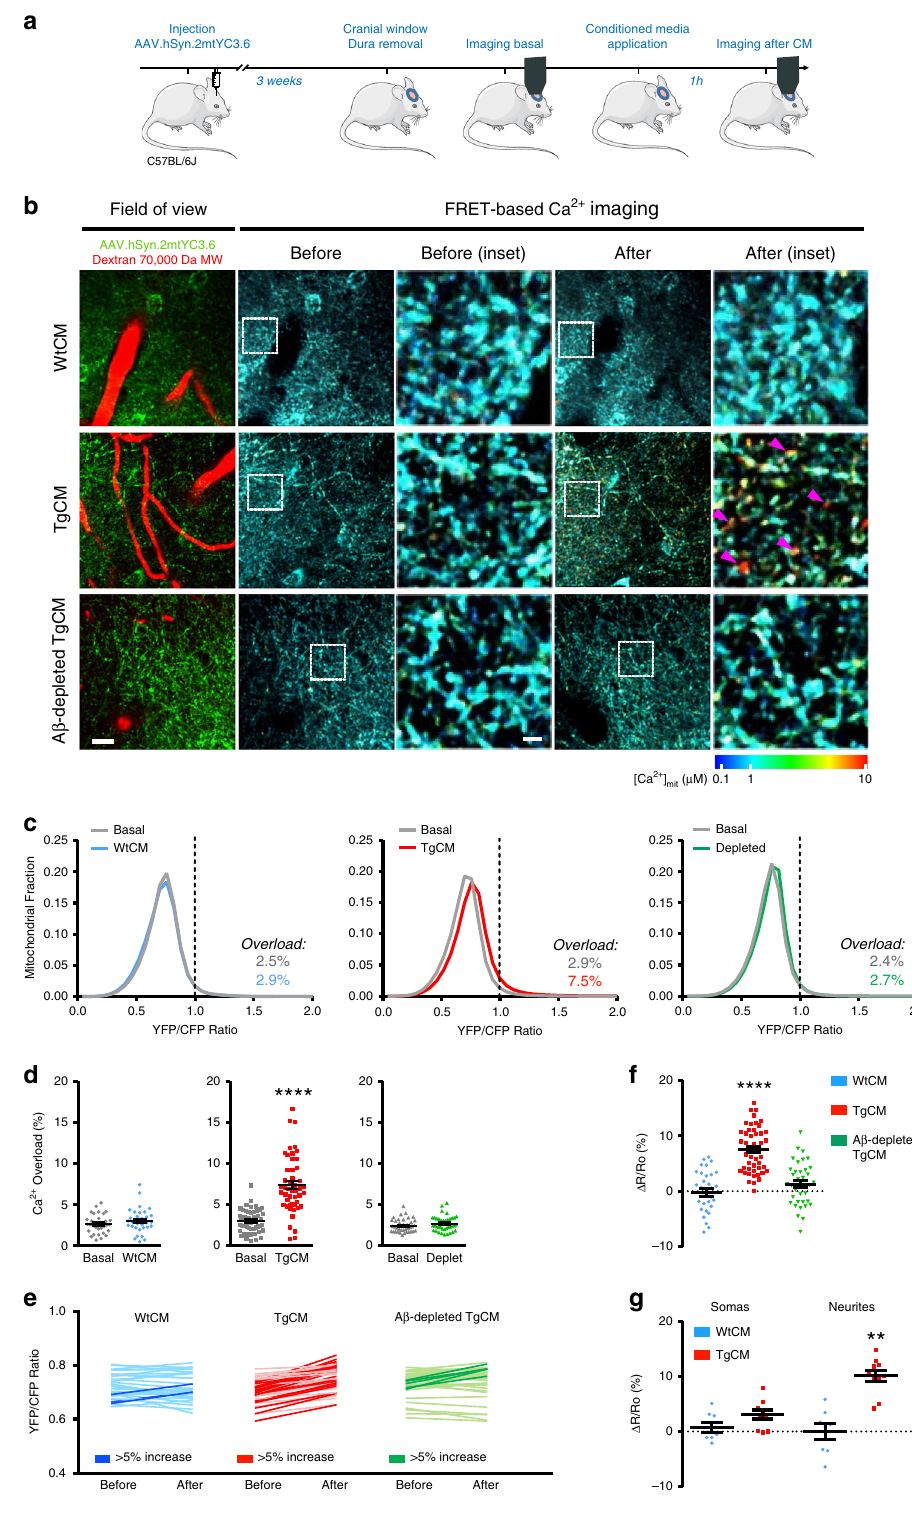
healthy neurons was spherical and chromatin was evenly somas at the fi rst imaging session (on average, YFP/CFP ratio distributed. Conversely, in neurons with high [Ca 2 + ] mit at ≥ 1.4, (~3093 nM [Ca 2 + ] baseline, the nucleus became condensed (likely undergoing mit )) were lost within 24 h (Fig. 7b, c). apoptosis), and the soma lost its of YFP/CFP fl uorescence None of the neurons exhibiting YFP/CFP ratio ≤ 1.4 disappeared (Fig. 7c). Despite being an occasional event in this model 40 , this in the second imaging session. We concomitantly injected Hoechst 33342 with hSyn.2mtYC3.6 to observe the nucleus and observation suggests a close correlation between high [Ca 2 + ] mit and neuronal cell